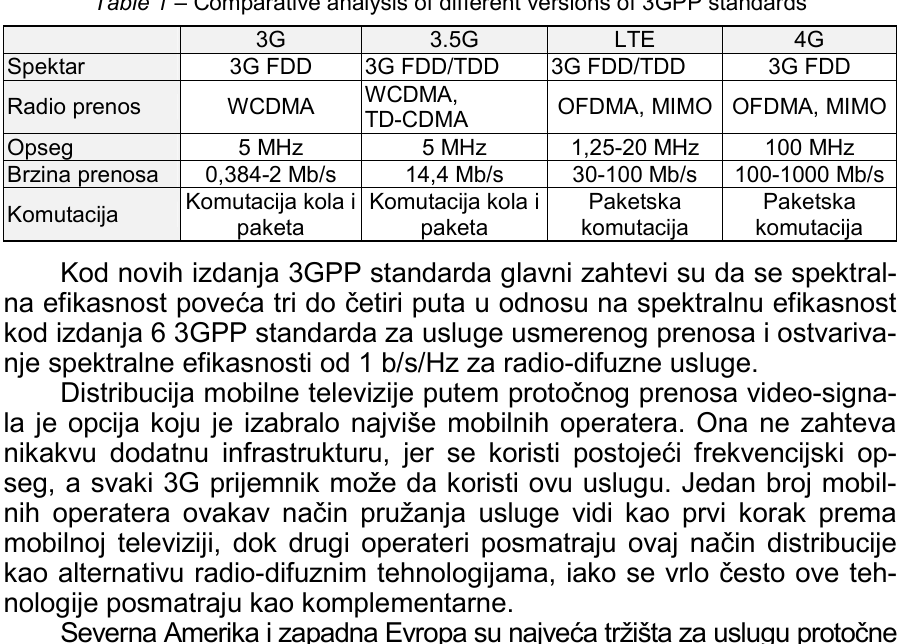
Table 1 – Comparative analysis of different versions of 3GPP standards 3G Spektar 3G FDD